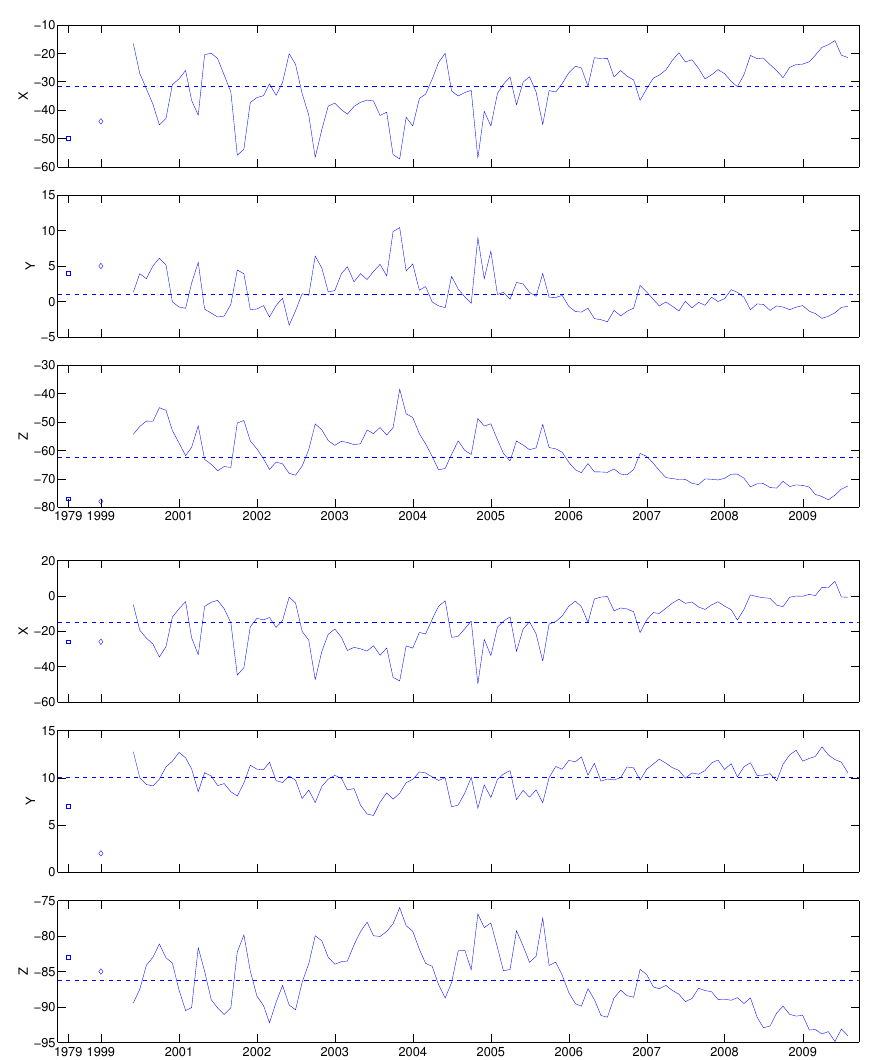
Figure 1. X , Y and Z monthly observatory biases over 9 years (June 2000–August 2009) at the NGK (top) and KAK (bottom) observatories, in nanoteslas. The average bias in each component is depicted by the dashed lines. The points at epochs 1979.92 and 1999.92 represent MAGSAT- and Ørsted-based biases computed by Mandea and Langlais